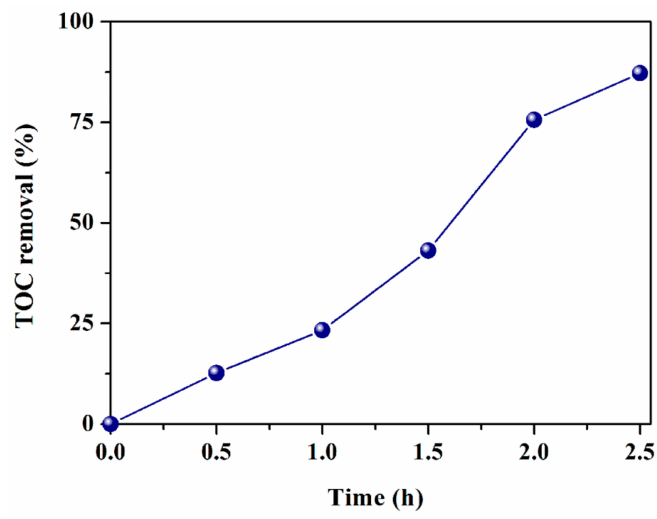
Figure 5. TOC removal profile of LEV (40 mg L − 1 , 200 mL) over 1.0CdS/Bi 2 MoO 6 (200 mg).